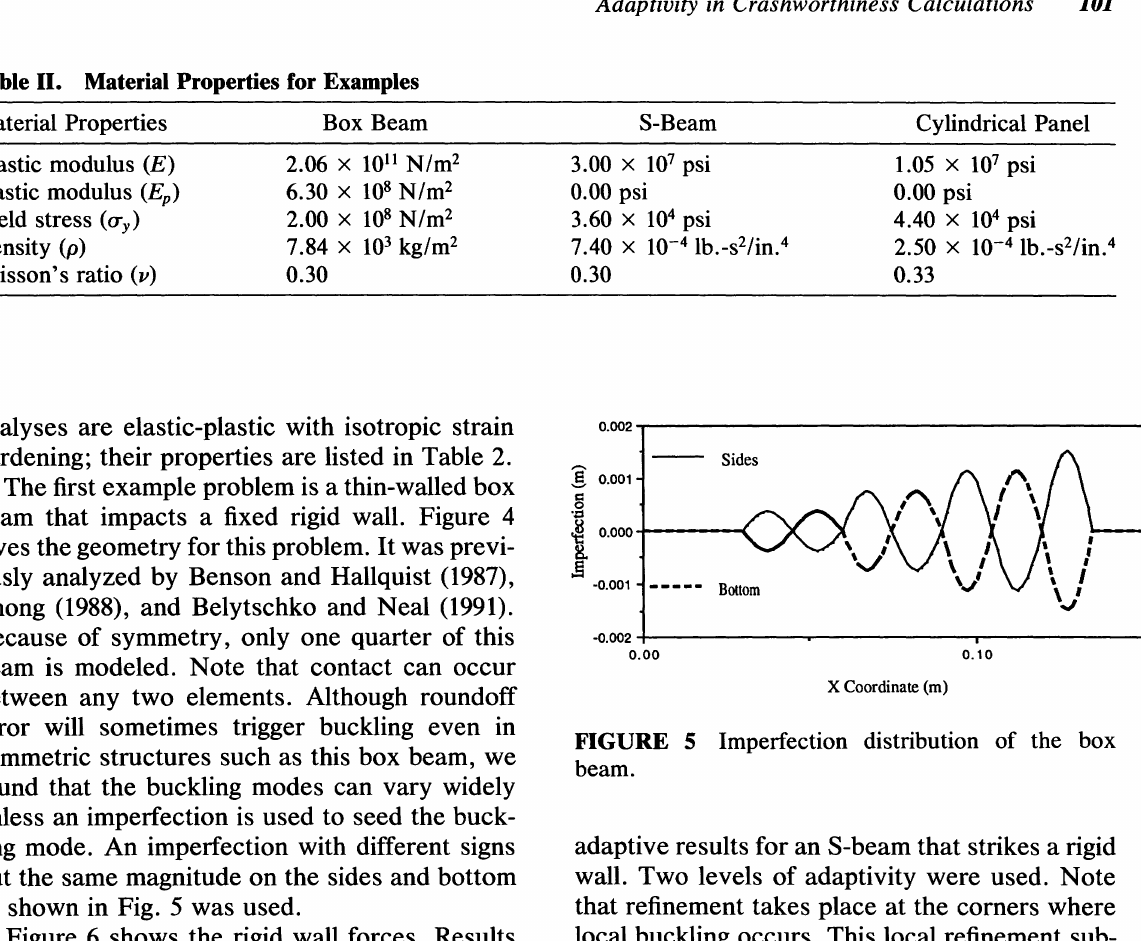
FIGURE 6 Time history of total force at the rigid wall for adaptive